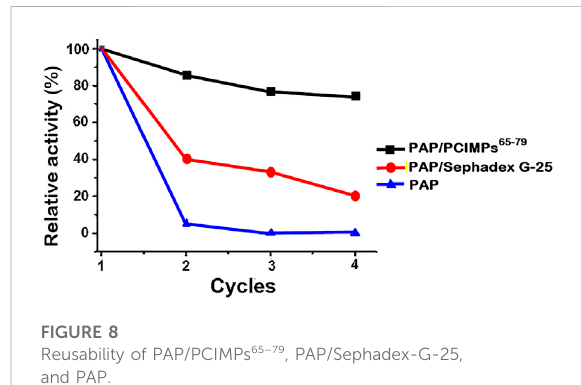
FIGURE 8 Reusability of PAP/PCIMPs 65 – 79 , PAP/Sephadex-G-25, and